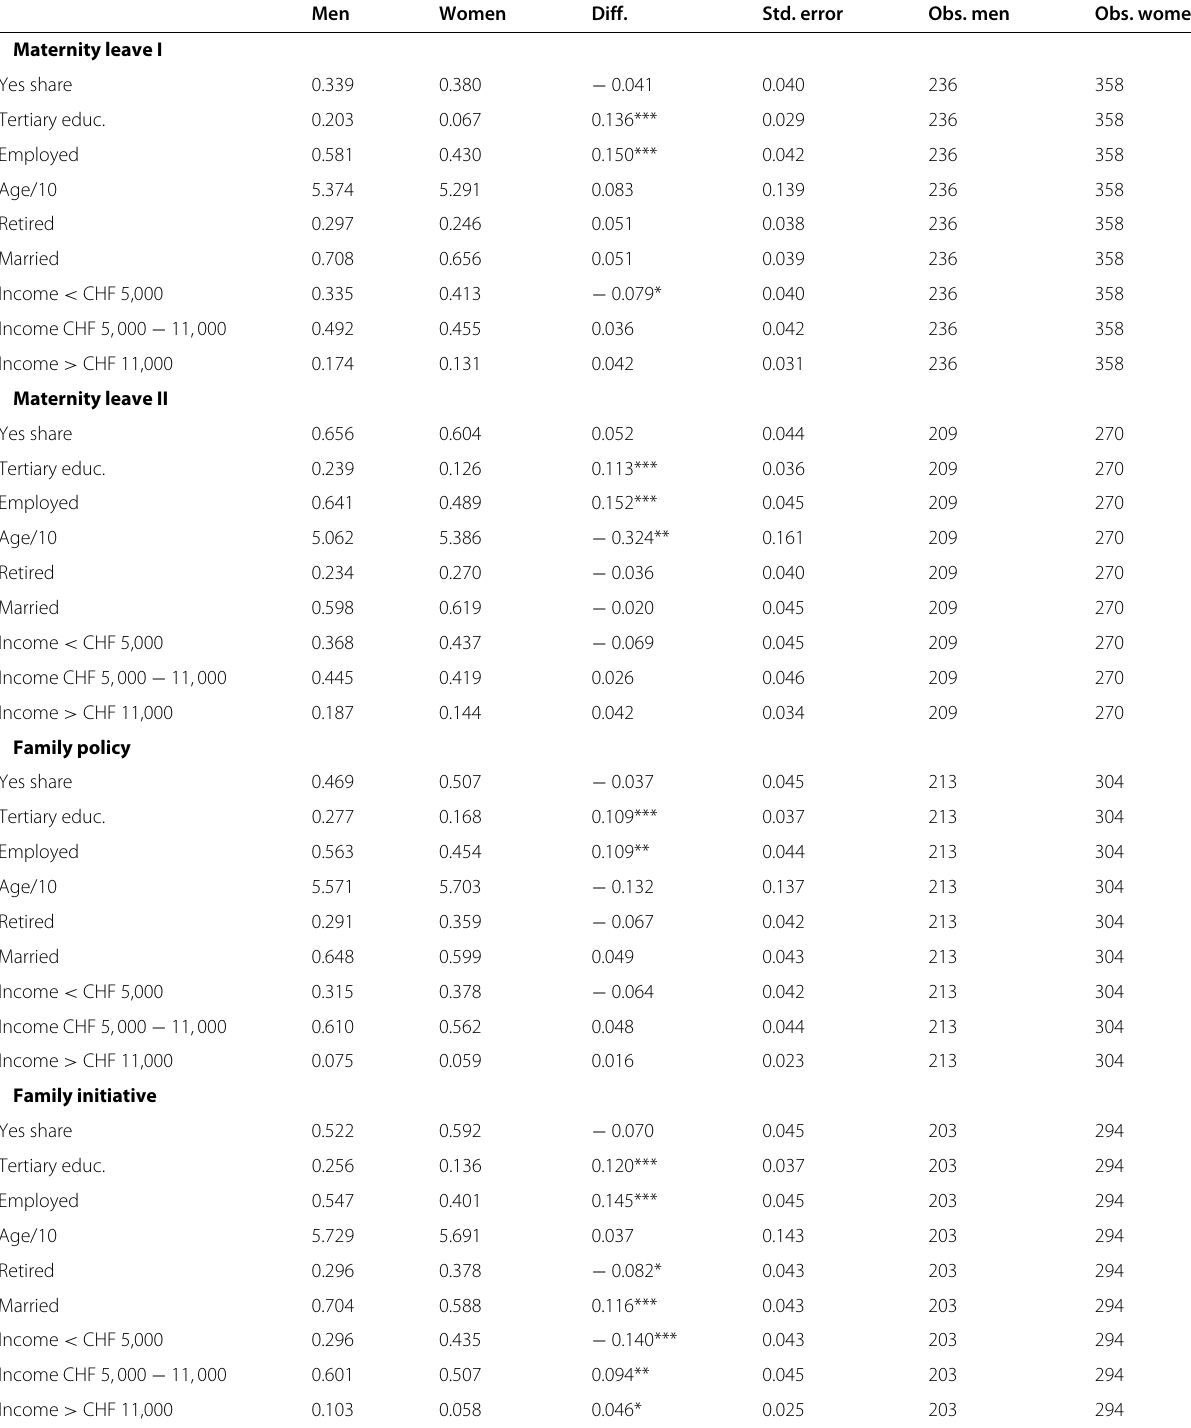
Table 5 Descriptive statistics of post-vote surveys Men Women Diff. Std. error Obs.